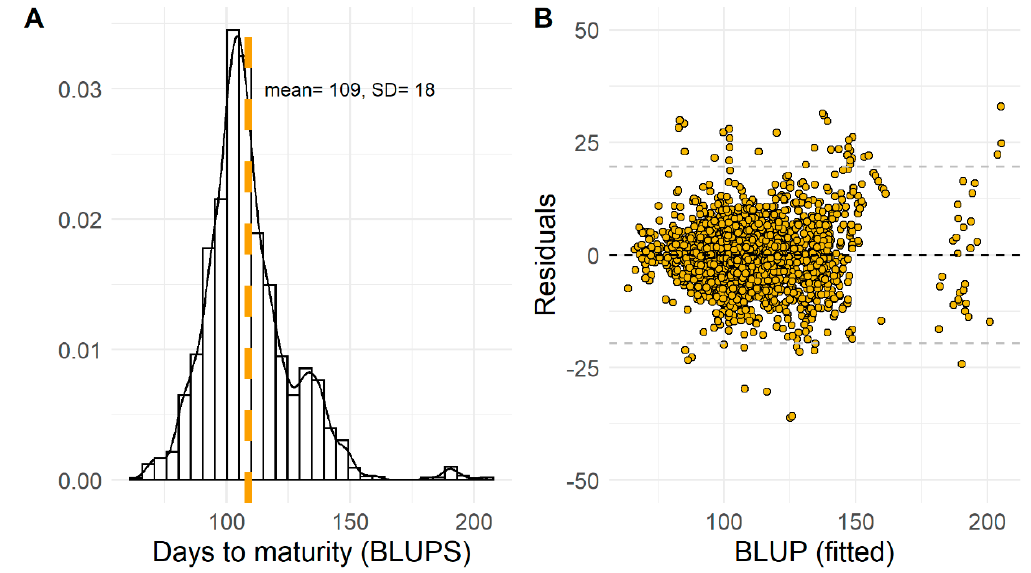
Figure 4. Soybean time to maturity (TTM) mean estimates, including best linear unbiased predictions (BLUPs) from an all-genotype–environment random-effects model (Panel A ). Residuals of the random-effects model (Panel B ). Dashed horizontal lines are the upper and lower threshold limits bounded within 3 SE. Mean TTM estimates were used as the target variable in the GAM soybean TTM model. Table 3. Soybean time to maturity (TTM) adjusted by genotype (G) and environmental (E) effects. The mean estimates of soybean TTM from this process were used as the target variables in the implementation of the GAM predictive model afterwards.